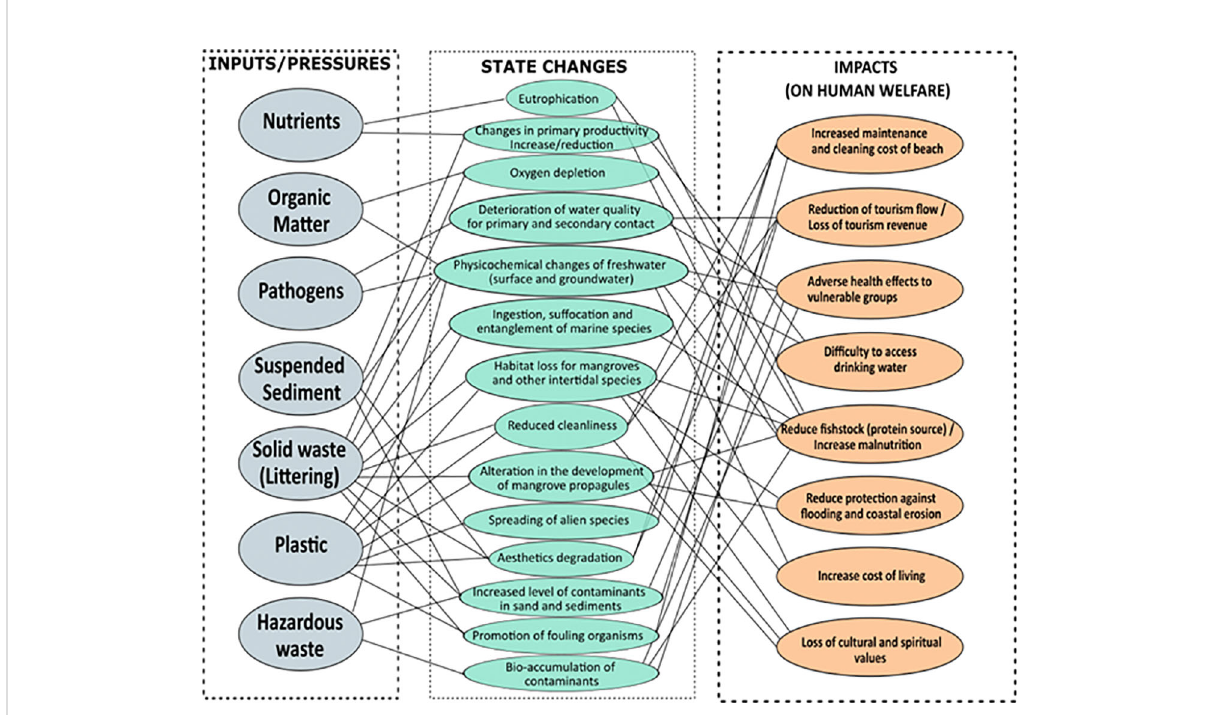
FIGURE 2 Pressures, State changes and Impacts horrendogram for the study area. Source: the authors with information from Fuentes-Gandara et al., 2018; Restrepo et al., 2018; Acosta-Coley et al., 2019; Rangel-Buitrago et al., 2019; Chacon et al., 2020; Portz et al., 2020;